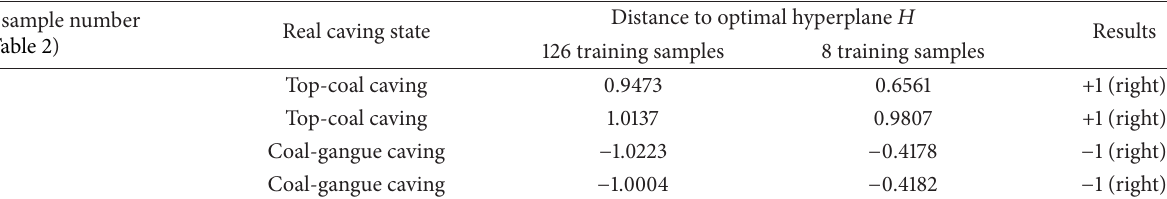
Table 4: Classification results of SVM under few samples.